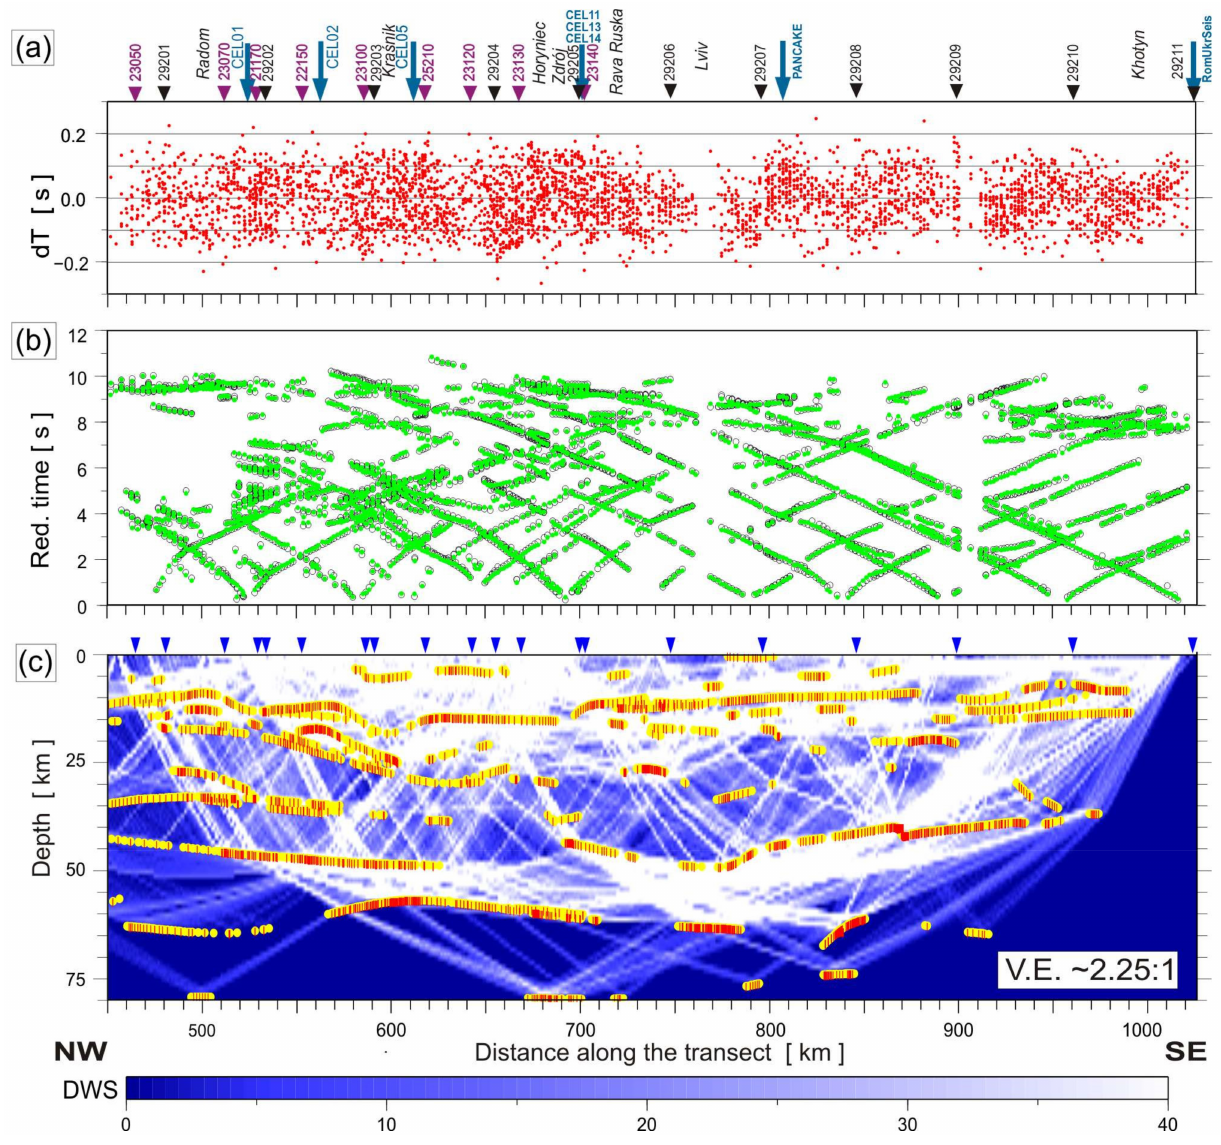
Figure 10. Diagrams showing: ( a ) Travel-time residuals ( b ) Theoretical and observed travel-times ( c ) Ray coverage from forward modelling along the profile. Green points—observed P-wave arrivals, black circles—theoretical travel-times. Yellow lines—elements of discontinuities constrained by reflected phases. The red points plotted along the interfaces mark the bottoming points of the modelled reflected phases (every third point is plotted) and their density is a measure of the location accuracy of the reflectors. DWS—derivative weight sum. Reduction velocity is 8